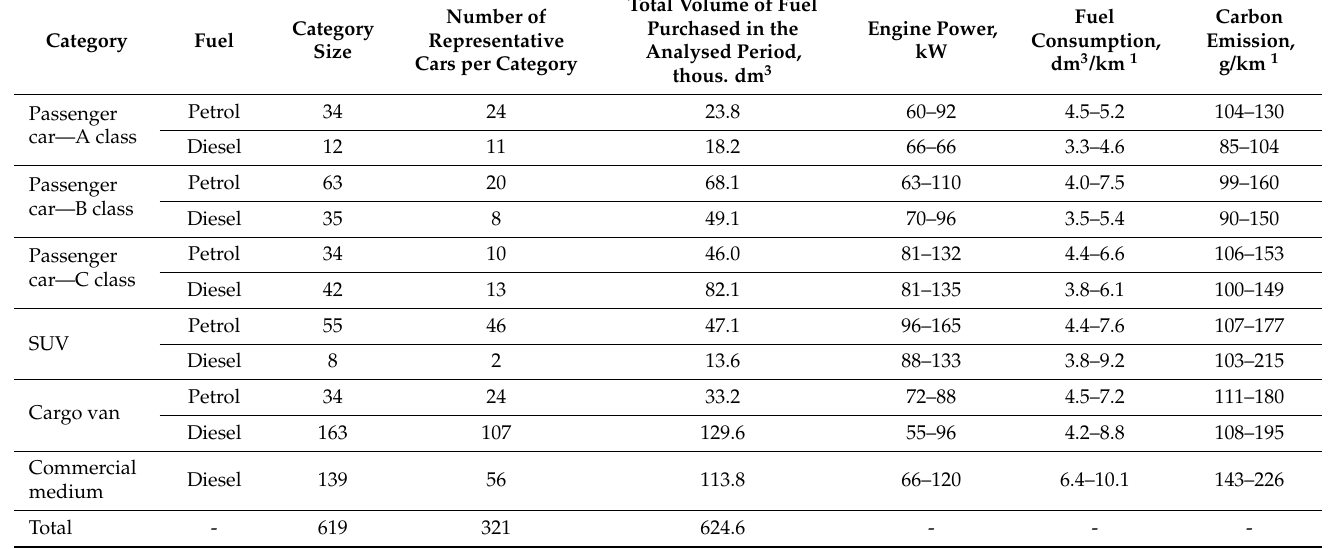
Table 1. Specification of ICE